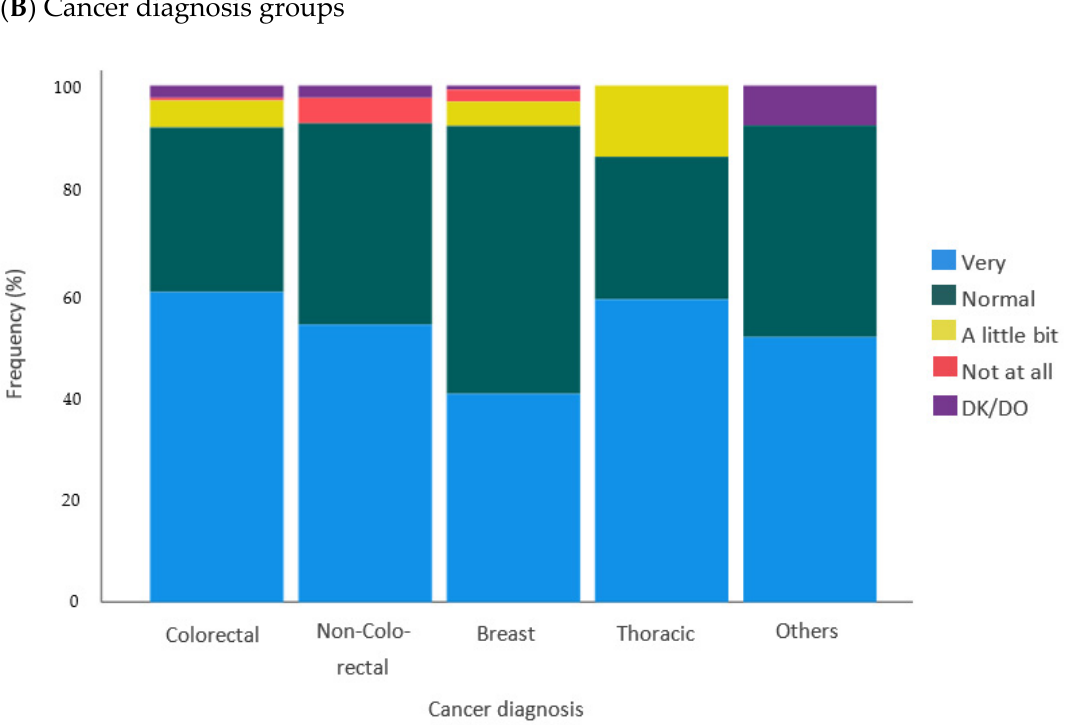
Figure 3. Second question (Q2) regarding sex group ( A ) and cancer diagnosis ( B ). Q4: Did the oncologists’ telephone visit comfort you regarding your disease and its control?